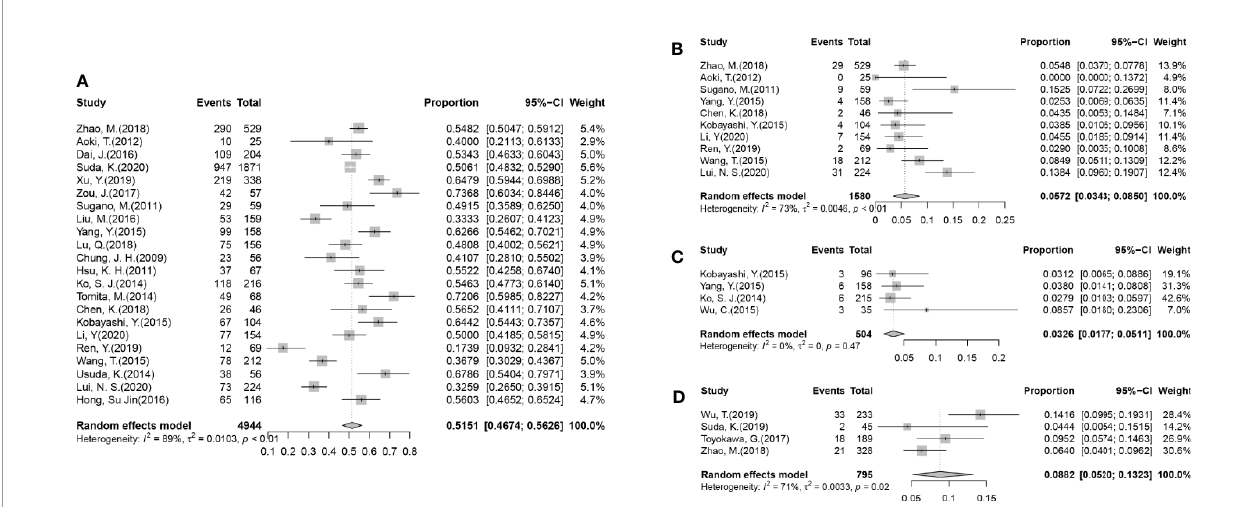
FIGURE 2 | Forest plots from the meta-analysis of published gene alterations in GGOs. (A) The pooled estimated rate of the EGFR mutation in 22 articles. (B) The pooled estimated rate of the KRAS mutation in 10 articles. (C) The pooled estimated rate of the ALK rearrangement in four articles. (D) The pooled estimated rate of the PD-L1 expression in four